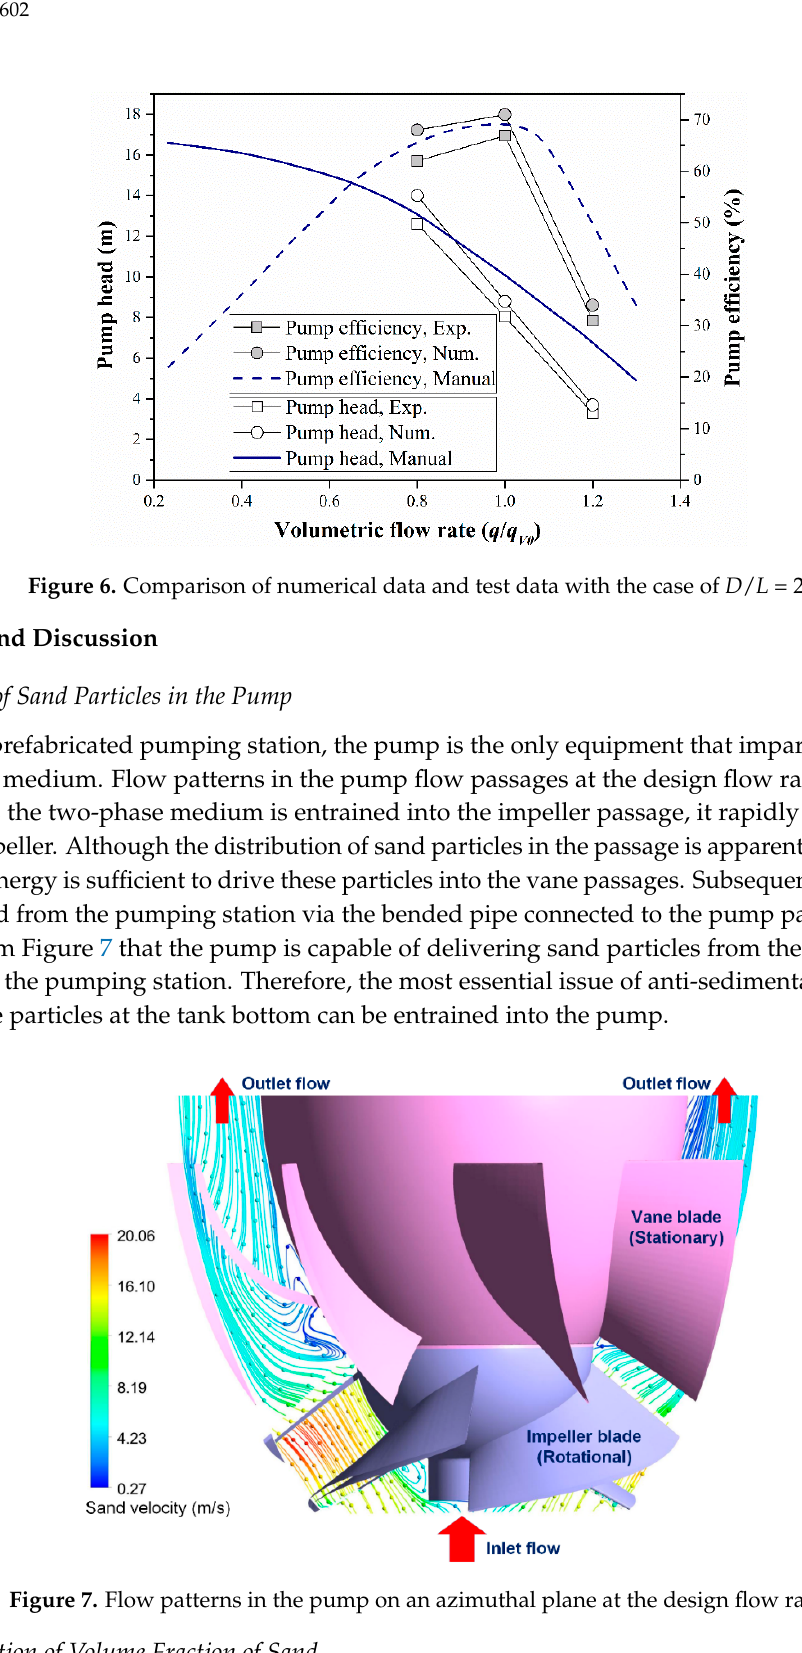
Figure 5. Experimental rig for the prefabricated pumping station. ( a ) Schematic view of major experimental facilities; ( b ) In situ image.